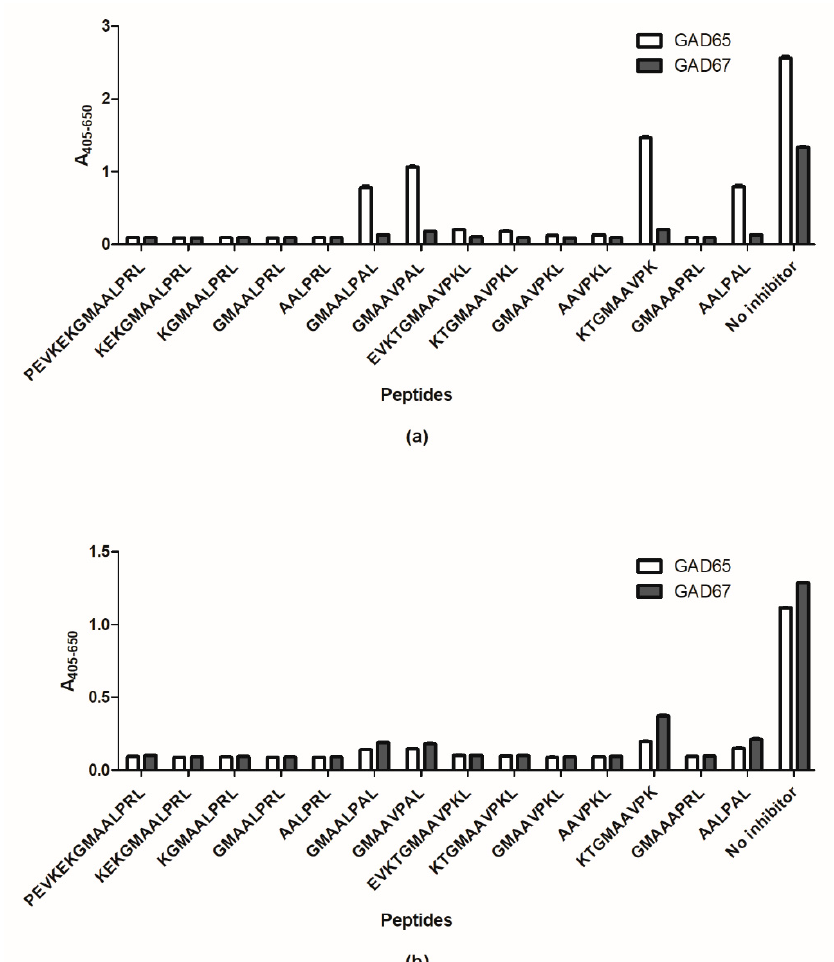
Figure 8. Identification of epitopes of SSI-HYB 386-01 and -02 analyzed by competitive inhibition assay. ( a ) Reactivity of SSI-HYB 386-01 to glutamic acid decarboxylase (GAD)65 and (GAD)67. ( b ) Reactivity of SSI-HYB 386-02 to GAD65 and GAD67.